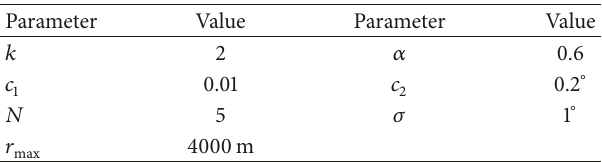
Table 1: Guidance parameters. Table 2: Impact angles and handover